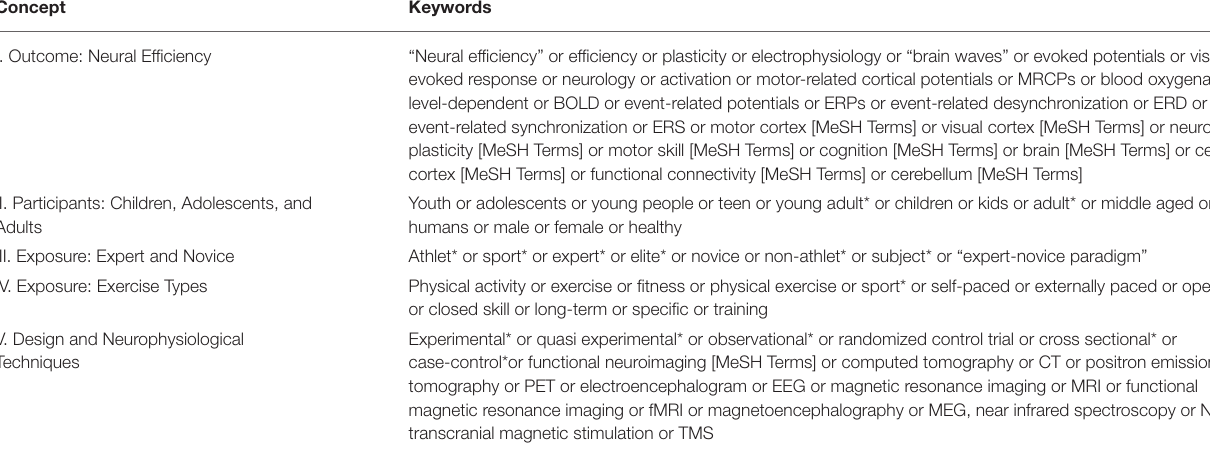
TABLE 1 | Flowchart of search strategy.